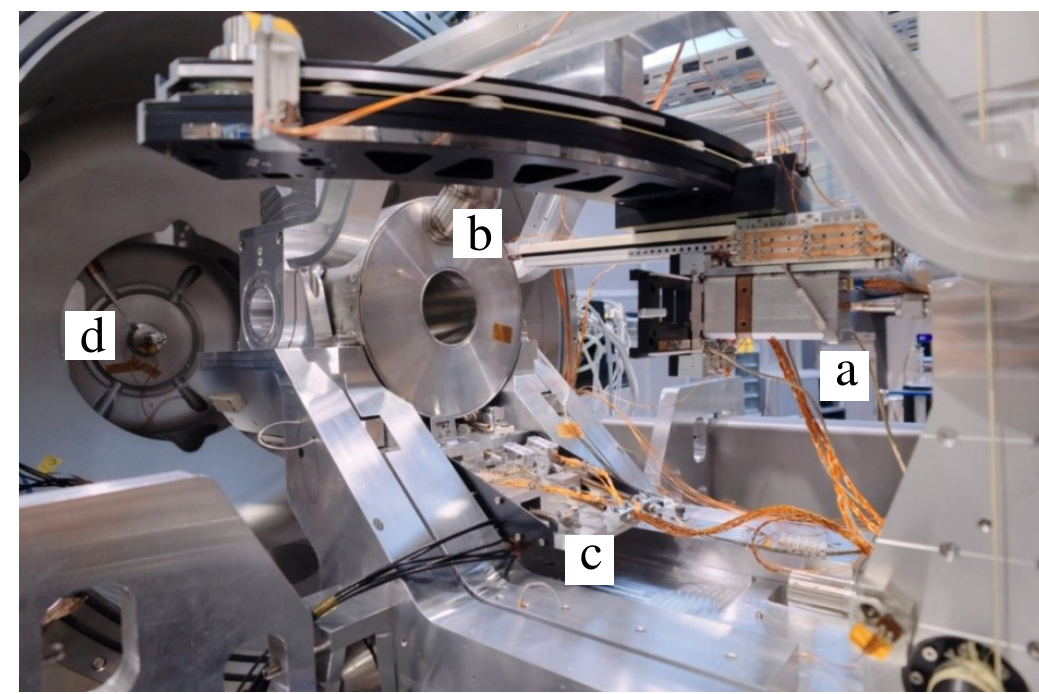
Figure 2: In vacuum view showing the detector unit (a), the magnet (b), partly the sample stage (c) and the di ff erential pumping stage